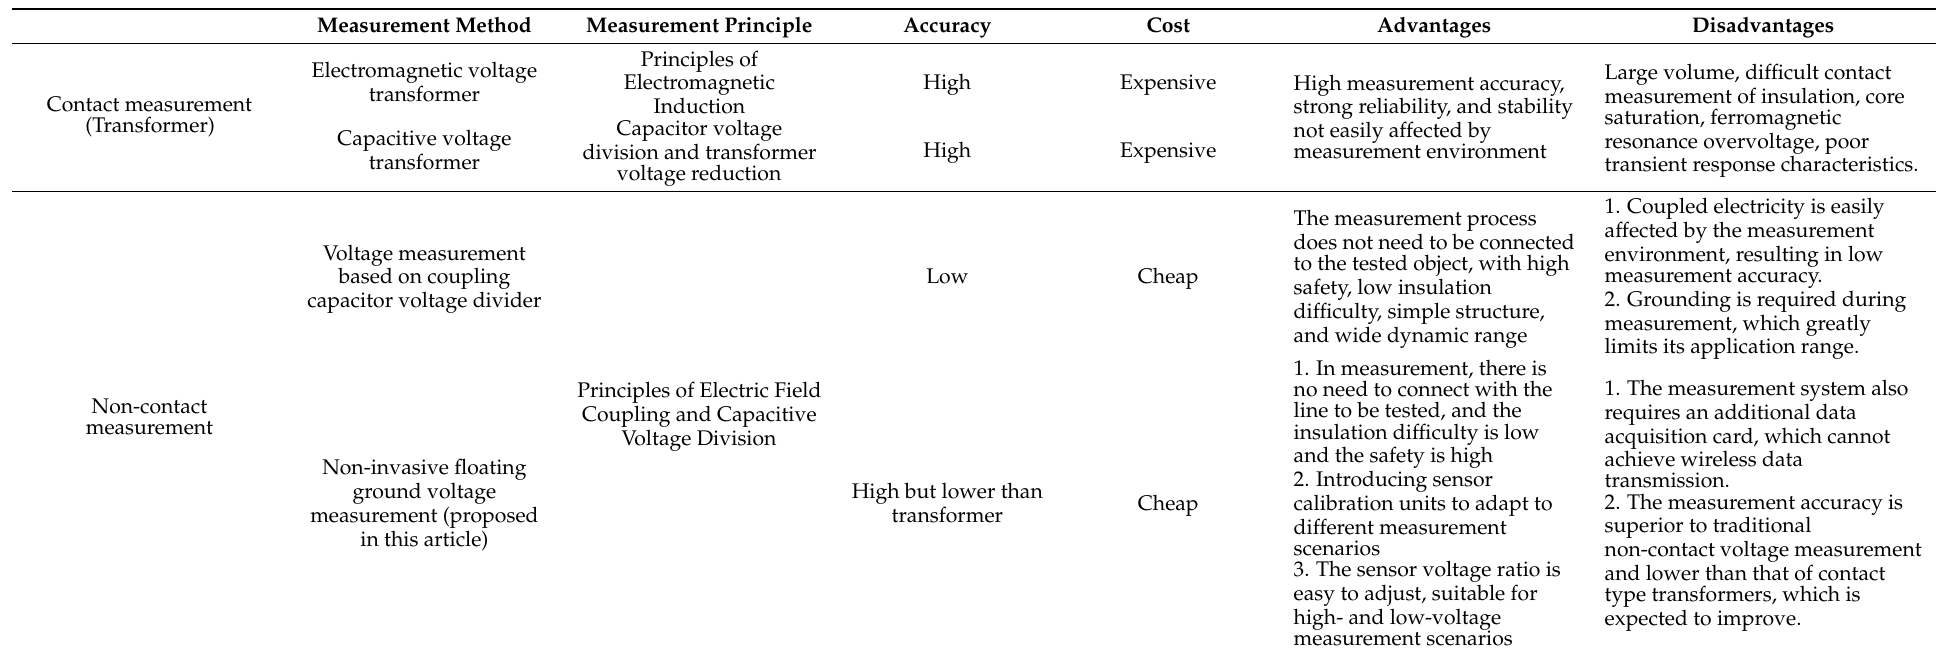
Table 5. Comparison of different measurement